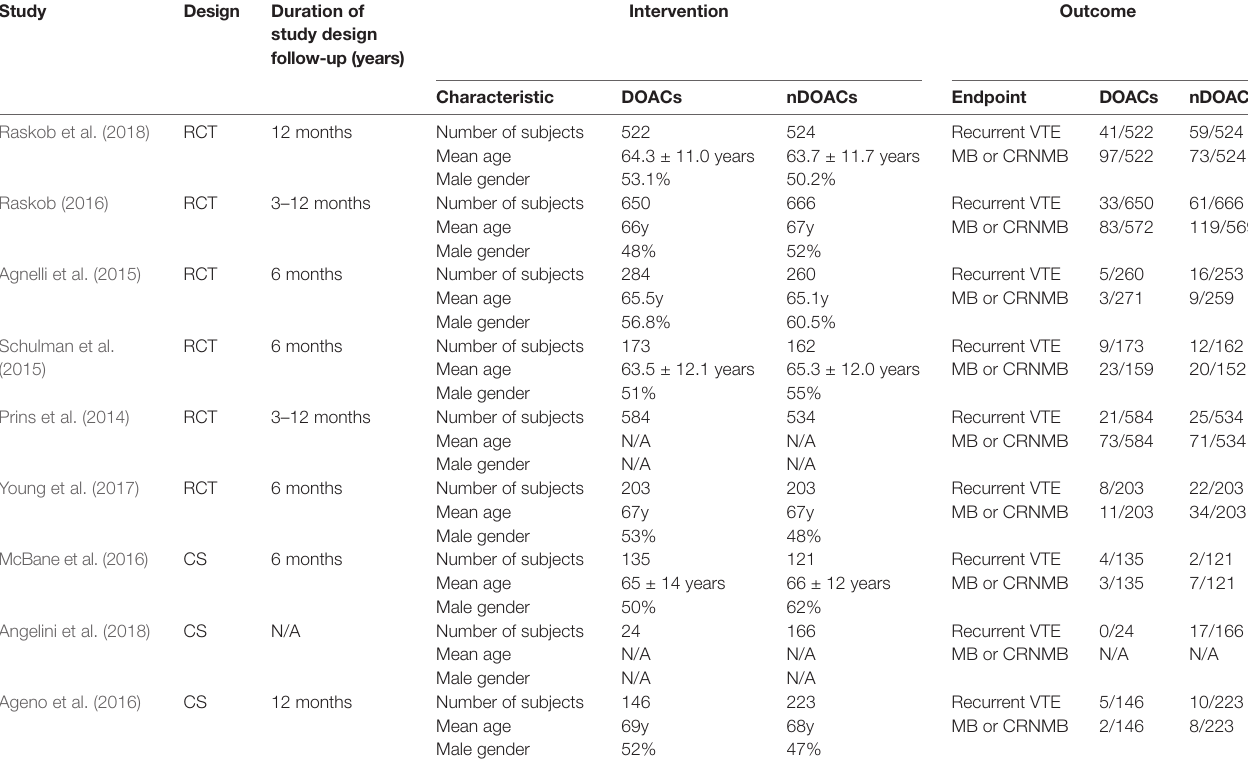
TABLE 3 | Baseline characteristics.